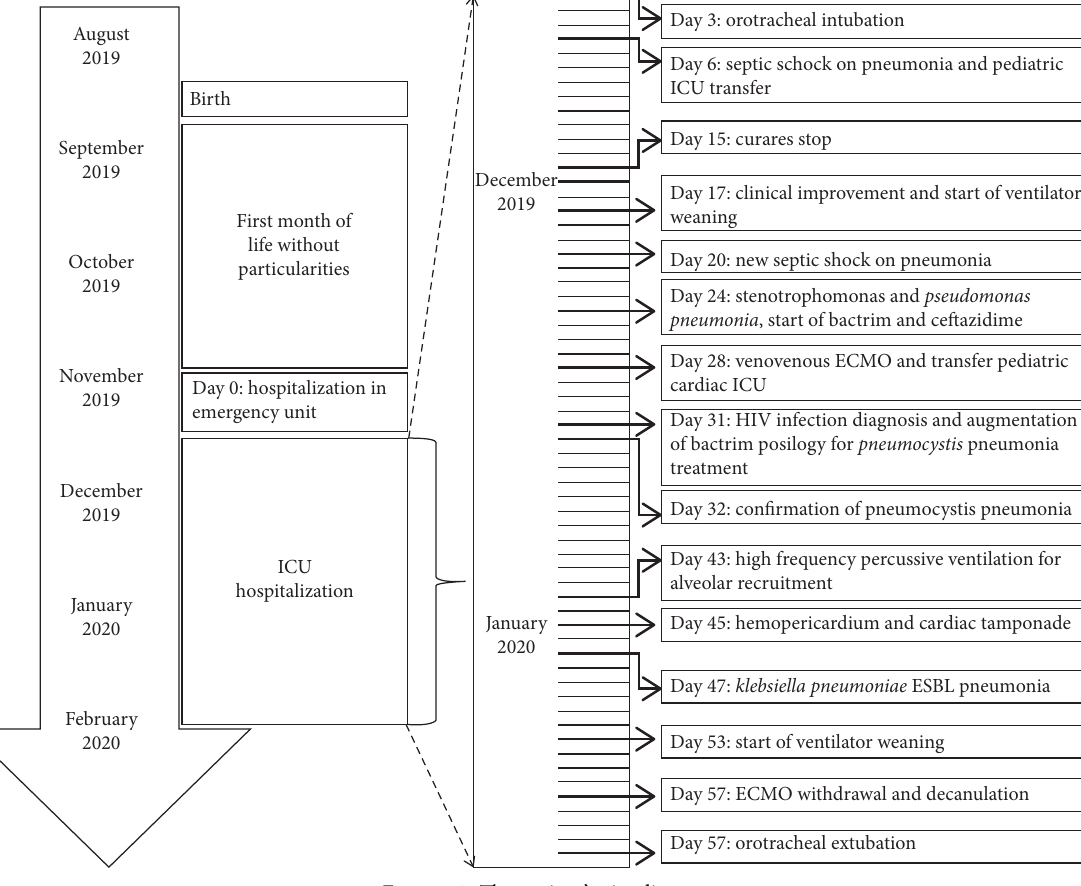
Figure 1: The patient’s